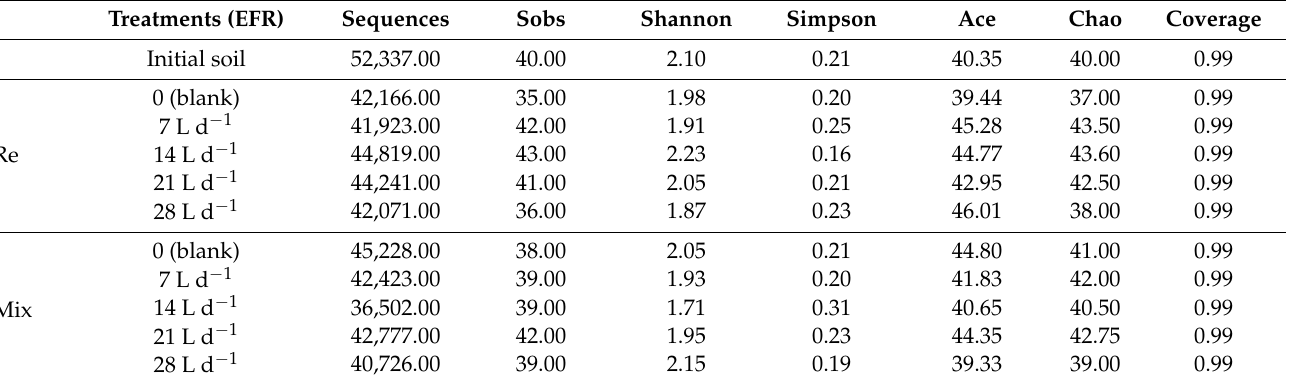
Table 3. Soil alpha diversity indexes in the different water exchange flow rates (EFR) for reclaimed and mixed